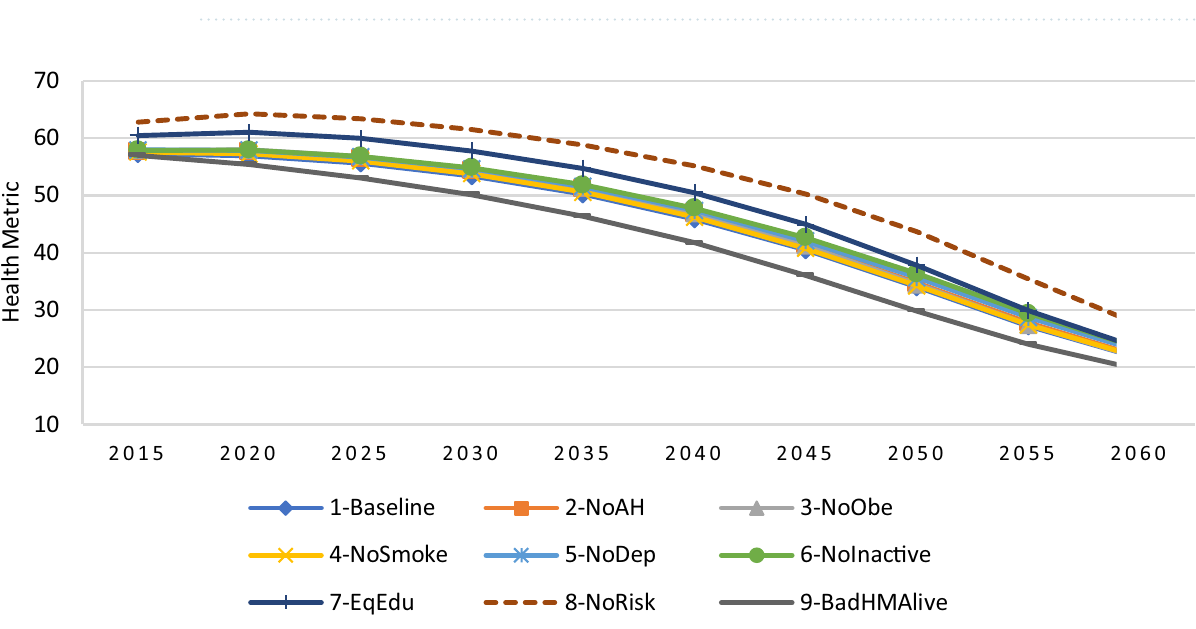
Figure 3. Projected average health metric and NYLP by education level for the cohort 1956–1960 under the baseline scenario.